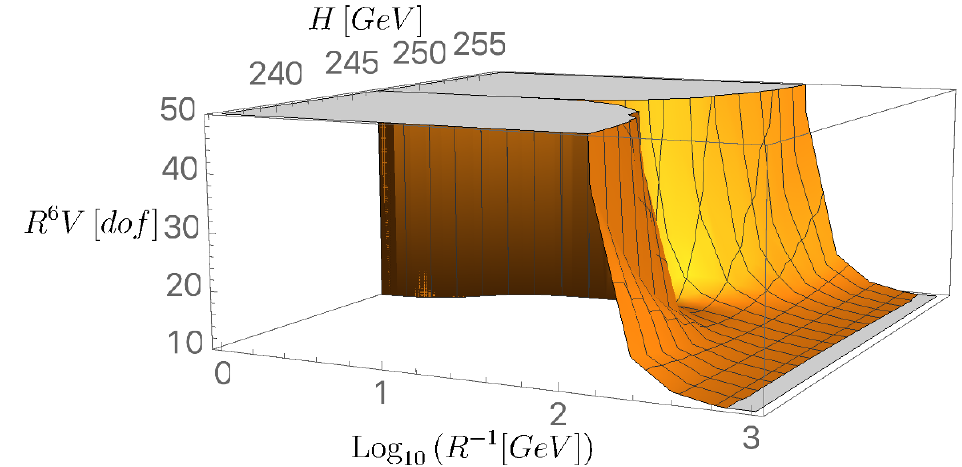
Figure 2 . E(cid:11)ective potential with the Wilson lines (cid:12)xed to zero, as a function of the Radion and the Higgs. The tree level potential dominates and the Higgs is not displaced from its tree level minimum by the one-loop corrections. This behavior is independent of the particular value of the Wilson lines Although not very visible in the plot, the Higgs minimum remains at the same location as R (cid:0) 1 increases.